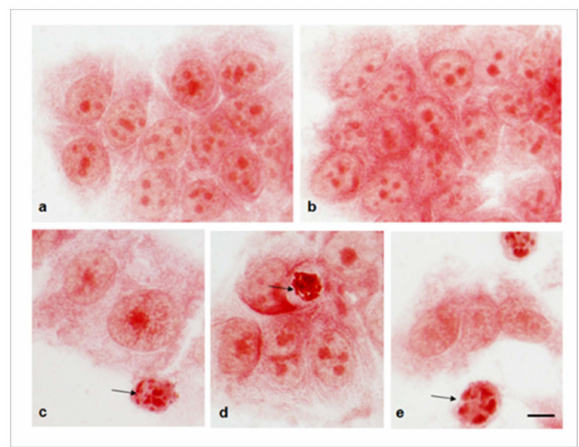
Figure 5. Morphology of MCF-7 cells stained with Neutral Red 48 h after treatment. ( a ) Control cells; ( b – e ) Cells incubated with AuNCs, AuNCs-D, AuNCs-S, and AuNCs-DS, respectively. Arrows indicate nuclei with apoptotic nuclear morphology (chromatin condensation and fragmentation). Scale bar: 10 µ